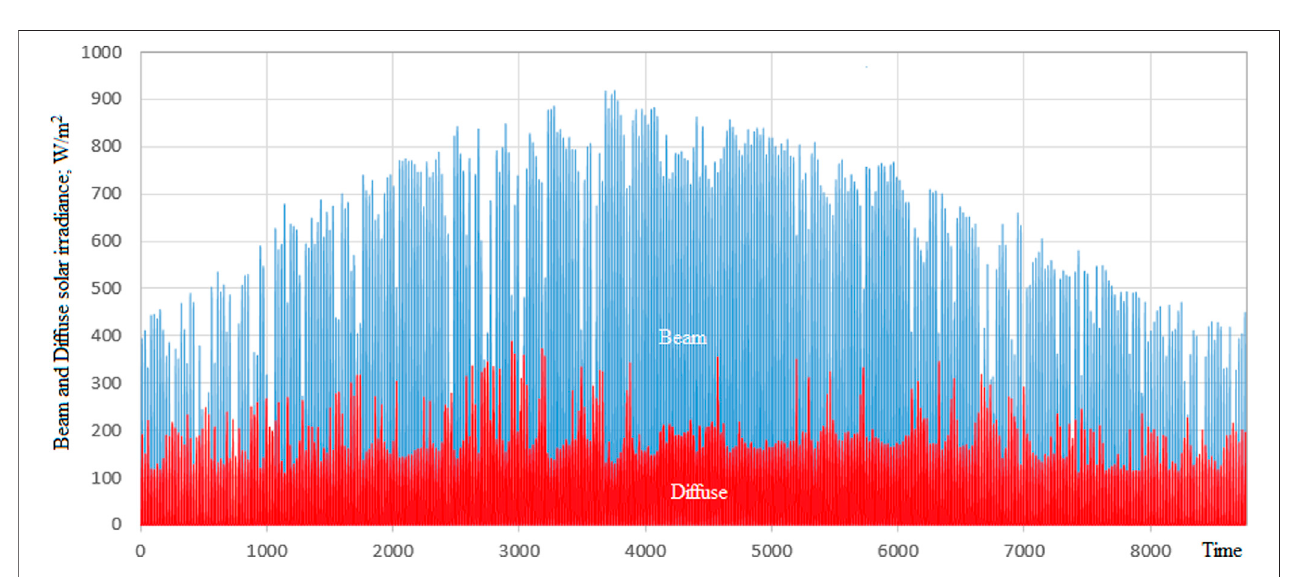
FIGURE 17 | Hourly horizontal beam and diffuse solar irradiance for Tripoli (32 . 815 ° N , 13 . 439 °